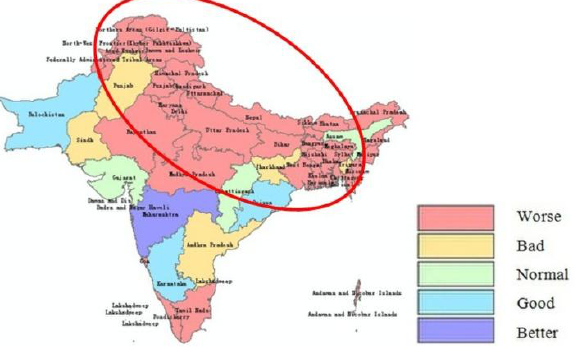
Figure 3. The strategic resource unit division of South Asia From figure 3, we can see that south Asia can be roughly divided into two units on the strategic resource factor, the worse northern and southern regions and the uneven distribution central region.